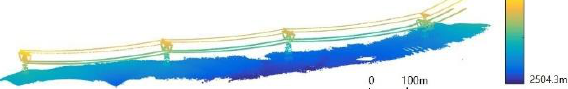
Figure 4. Point cloud of power line corridor in gentle slope topography. The colour bar represents the real height range.